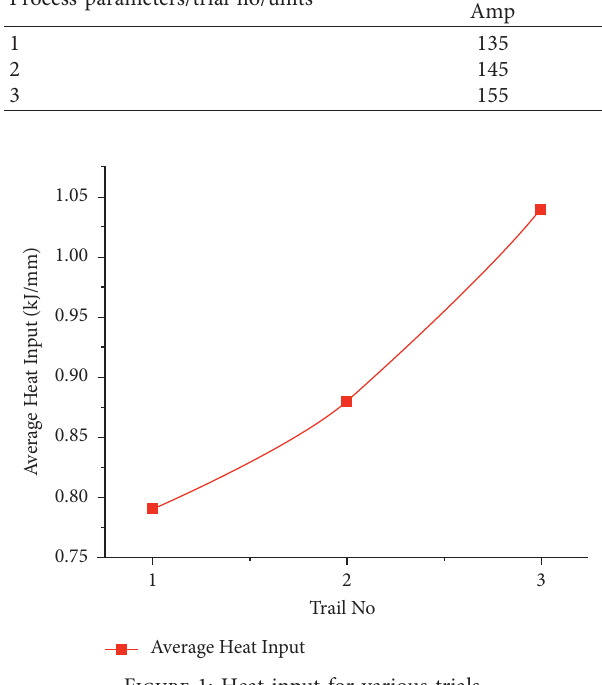
Figure 1: Heat input for various trials.